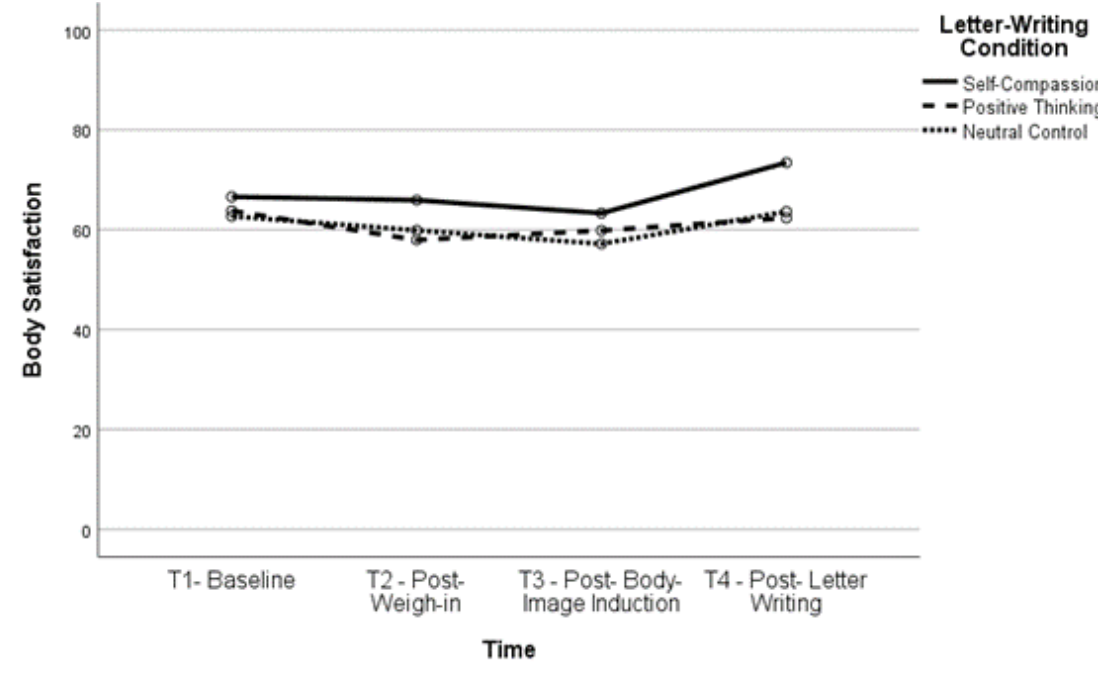
Figure 1. Body Satisfaction Over Time for Lower BMI Group.